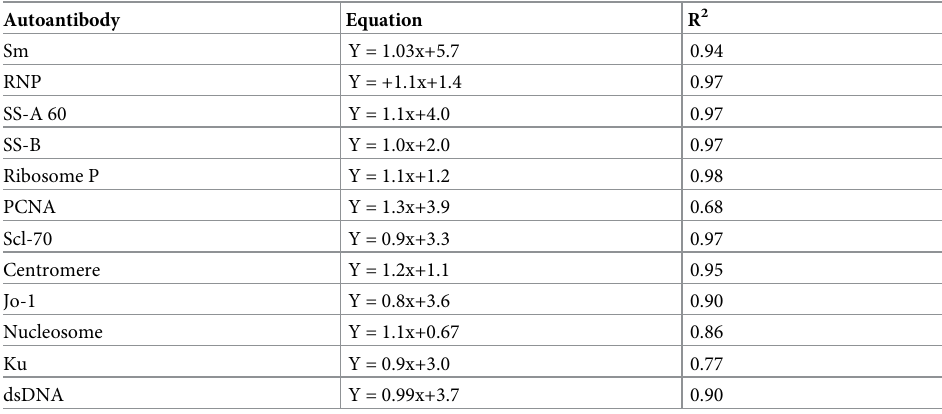
Table 4. Whole blood vs serum correlations for ANA 12